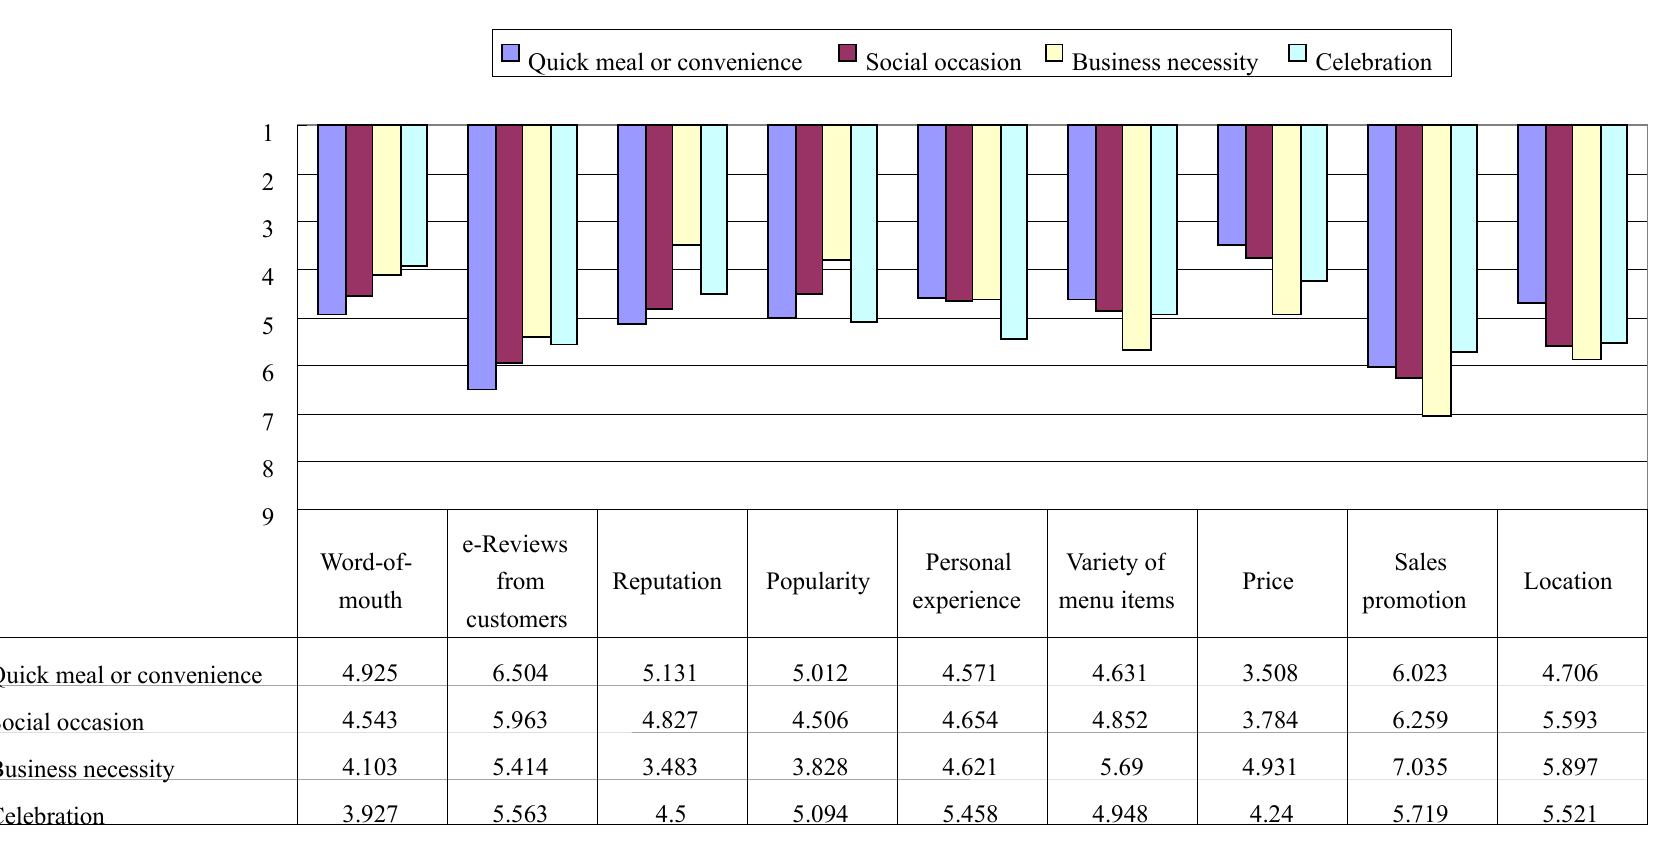
Figure 2. Ranking by eating-out occasions. 1: “The most important criteria to consider when choosing a restaurant”; 9: “The least important criteria to consider when choosing a restaurant”. Quick meal/convenience ( n = 252), Social occasion ( n = 162), Business necessity ( n = 29), Celebration ( n =